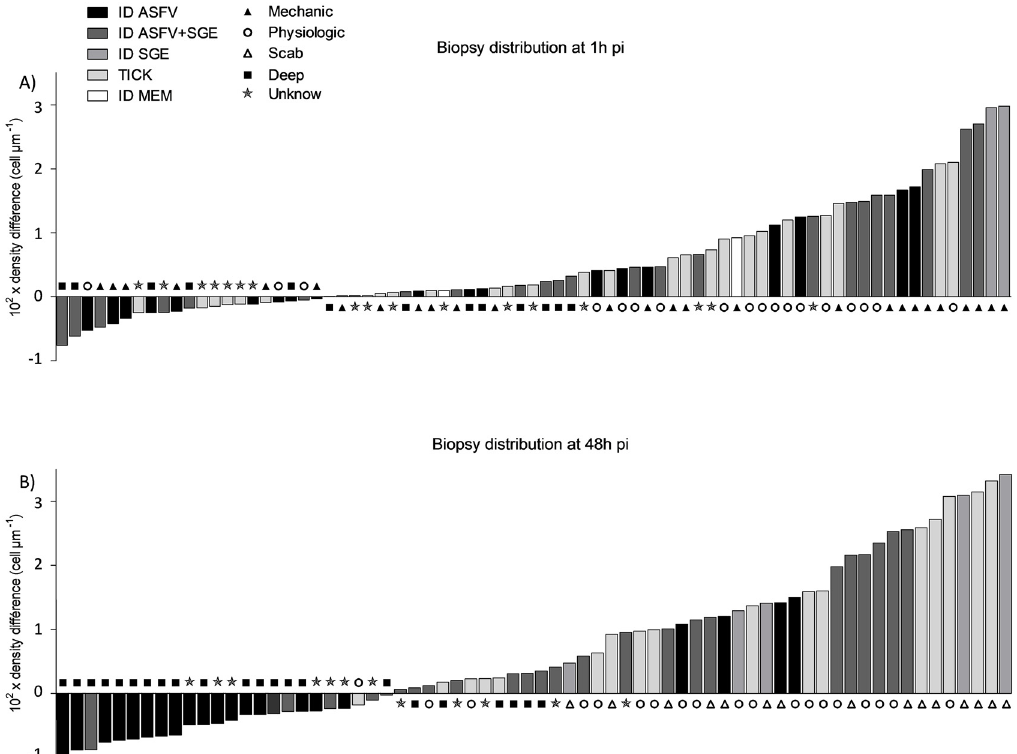
Fig 3. Classification of biopsies by Langerhans cell density differences and associated histological lesion pattern. (A) Classification of biopsy at 1 h pi. (B) Classification of biopsy at 48 h pi. Results of manual count and observation carried out on each slide. Two main lesion patterns were observed, one due to the tick bite or to the intradermal inoculation (pattern: mechanical or deep) and the other due to the physiological effect of saliva, SGE and virus (pattern: no-effect, physiological or scab).